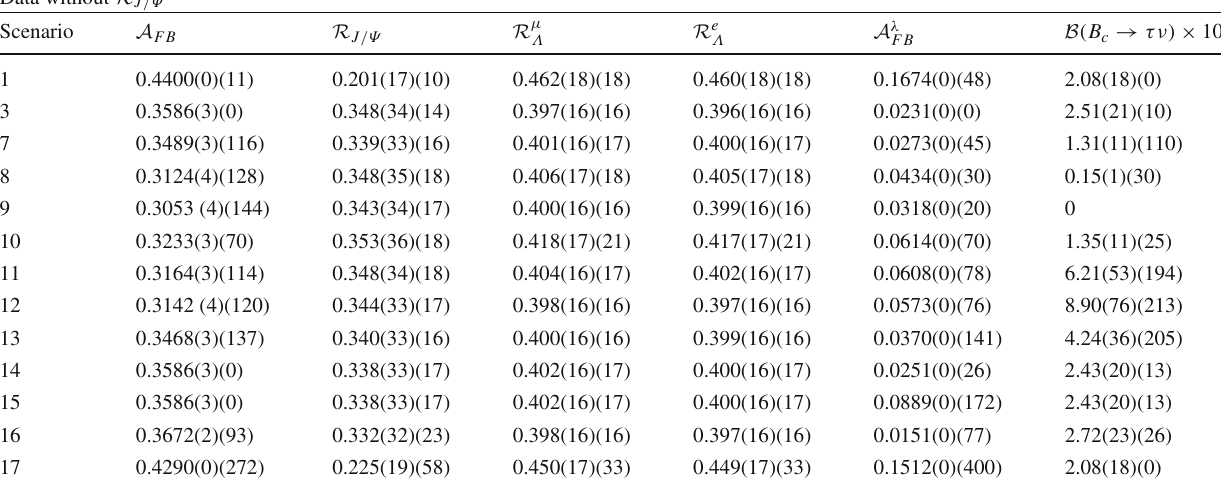
Table 9 Prediction of observables, continued from Table 8